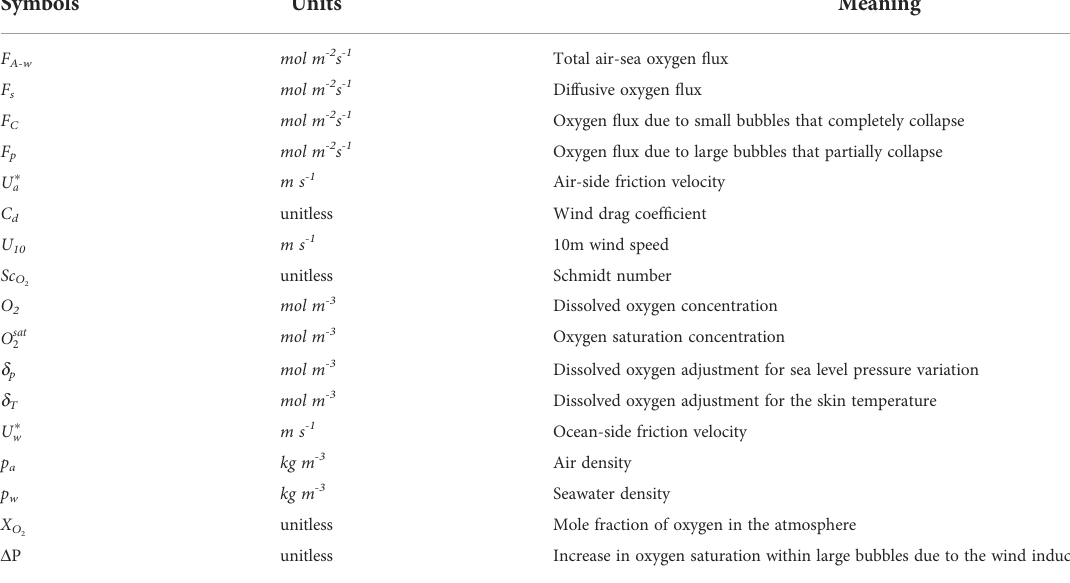
TABLE 1 The meaning of symbols used in Section 2.4.2 and their units.